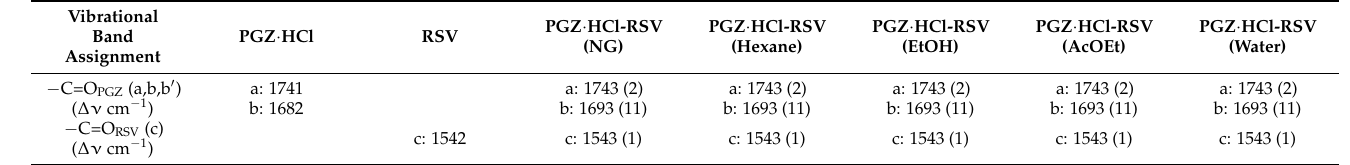
| ∆ ν cm − 1 | = vibration mode of pure drug — vibration mode of binary solid